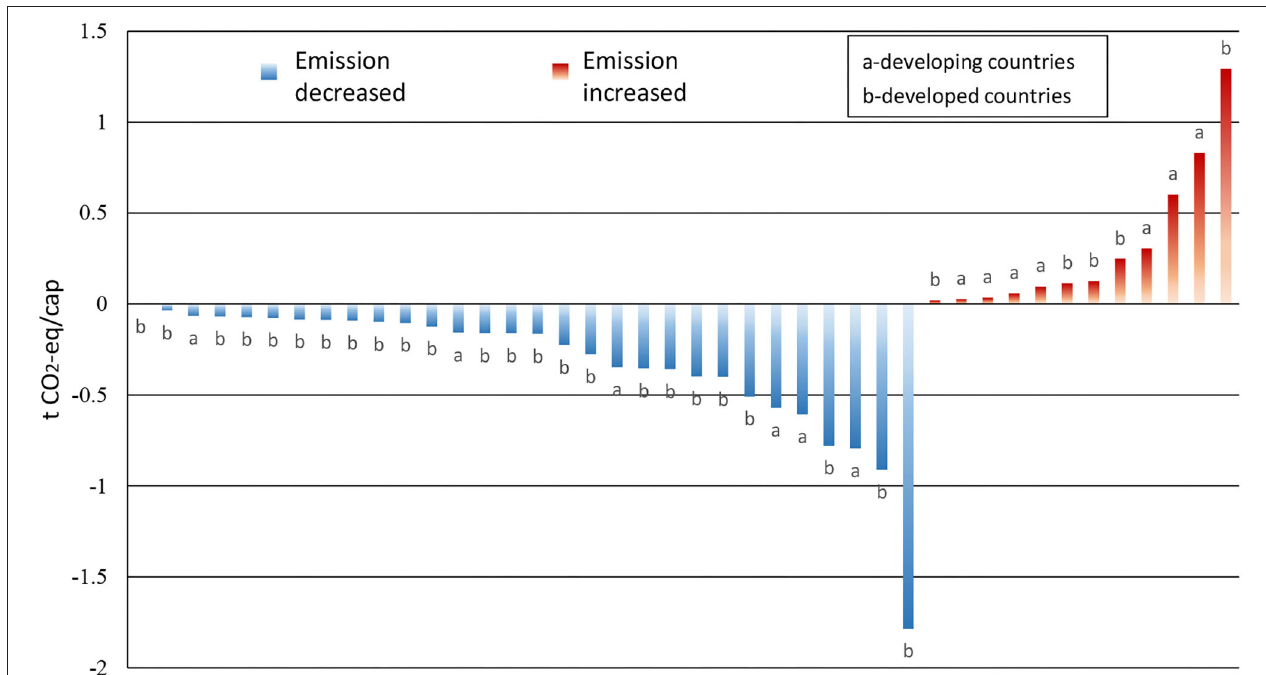
FIGURE 4 | Annual change of per capita GHG emission in cities over 2005–2016. 1, Yokohama; 2, Paris; 3, Chennai; 4, Barcelona; 5, Milan; 6, Stockholm; 7, Los Angeles; 8, Seoul; 9, New York City; 10, Vancouver; 11, San Francisco; 12, Durban; 13, Toronto; 14, Chicago; 15, Austin; 16, Boston; 17, Washington, DC; 18,